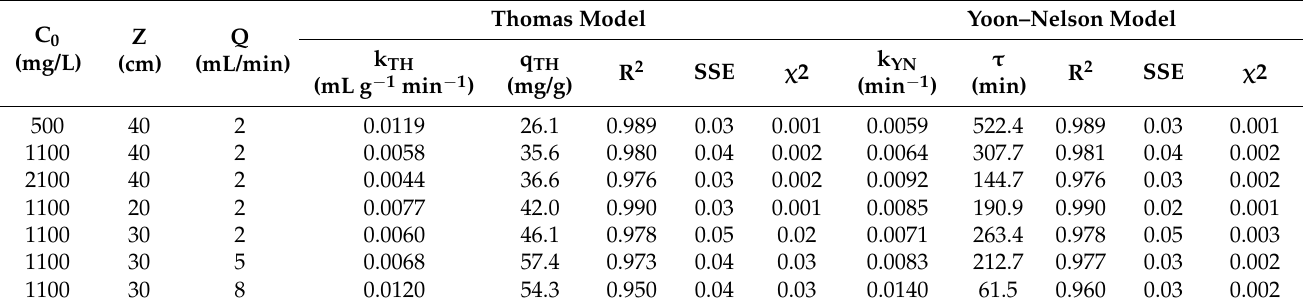
Table 5. Error analysis for both Thomas and Yoon–Nelson